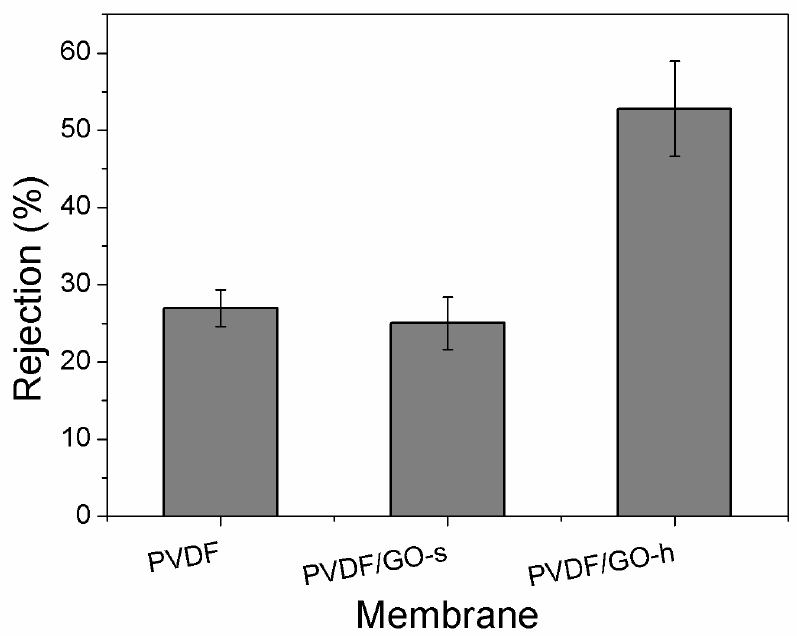
Figure 6. Water rejections of the prepared PVDF, PVDF/GO-s and PVDF/GO-h membranes (PEG 35 K).